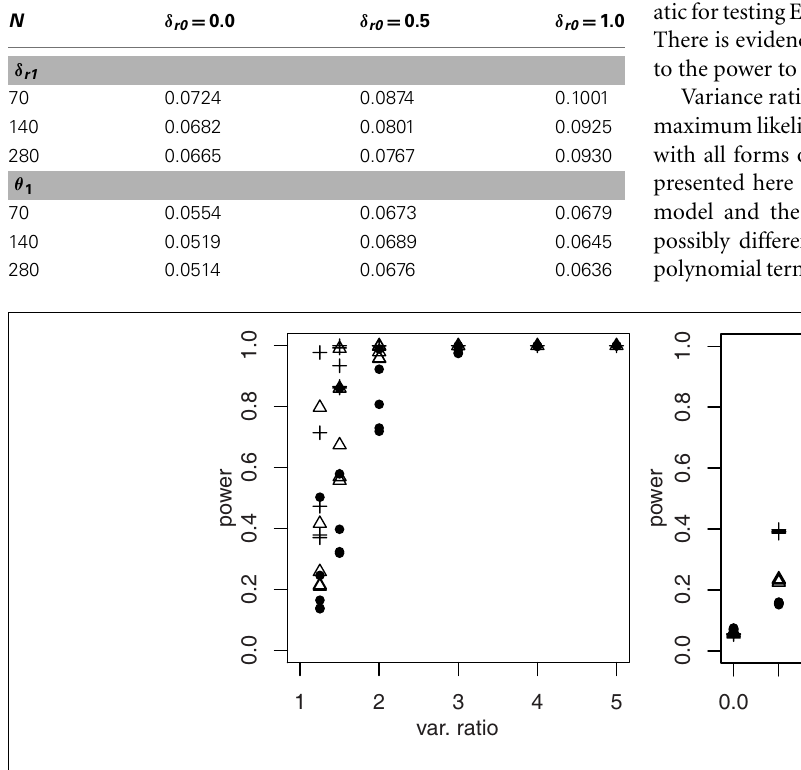
Table 7 | Simulations fromAzzalini distribution with λ = 2.